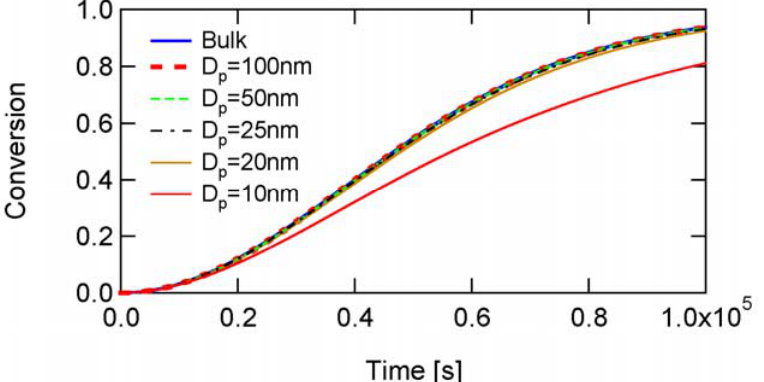
Figure 10. Conversion development of RAFT-01, with various particle